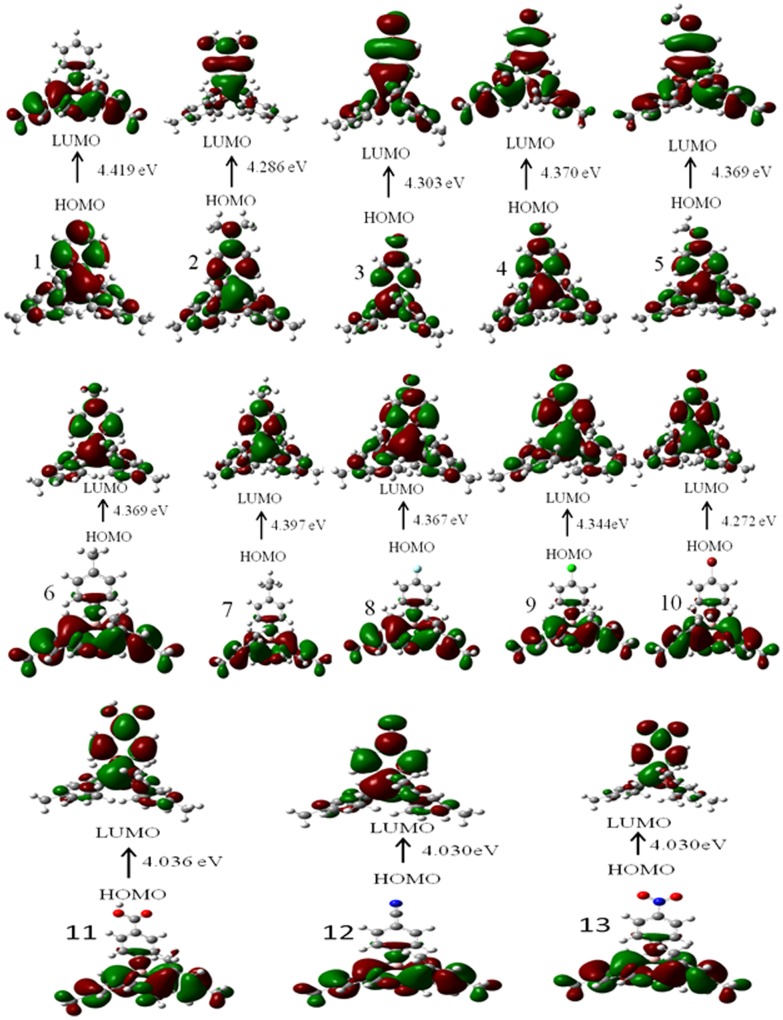
The frontier molecular orbitals (FMOs) of DMB derivatives at DFT/B3PW91/6-311G (d,p)++ level of theory.